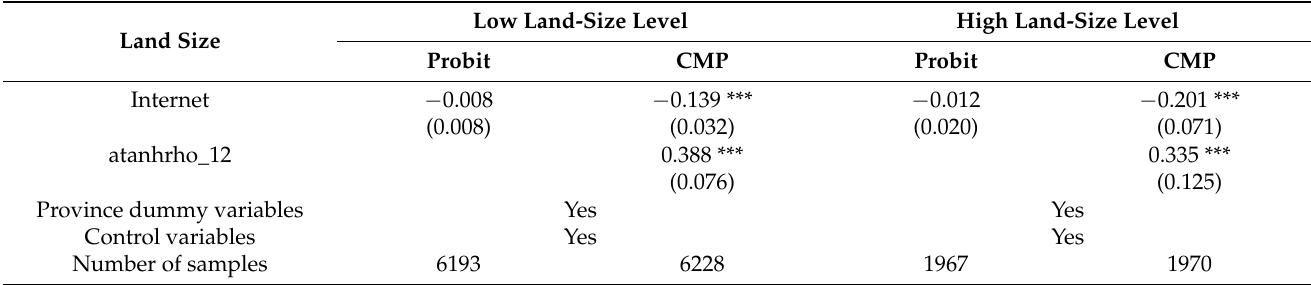
Table 3. Land-size regression results.